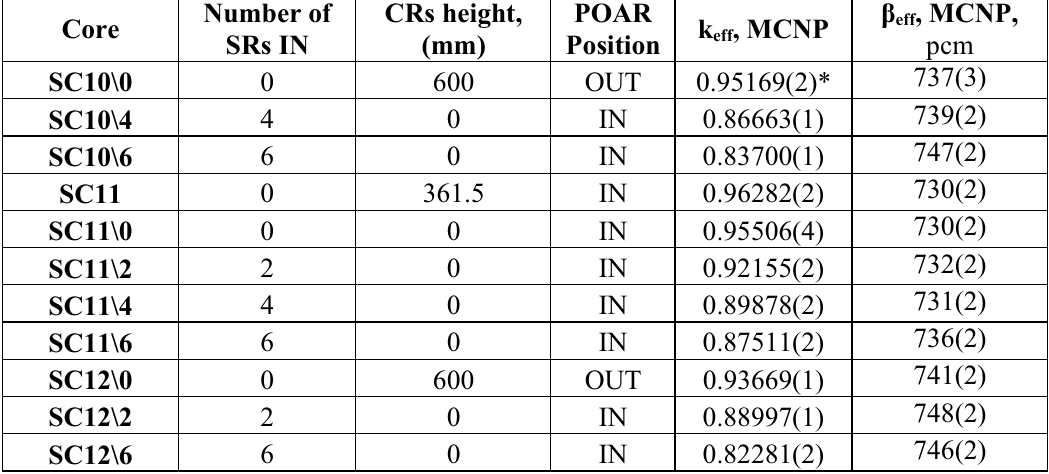
Table I. The SC10, SC11 and SC12 core variants that have been